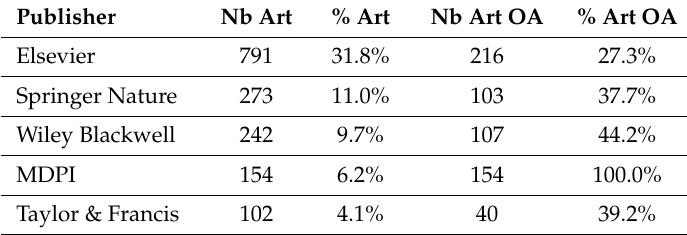
Table 10. Most important publishers with number and share of articles and OA articles ( n = 2489).